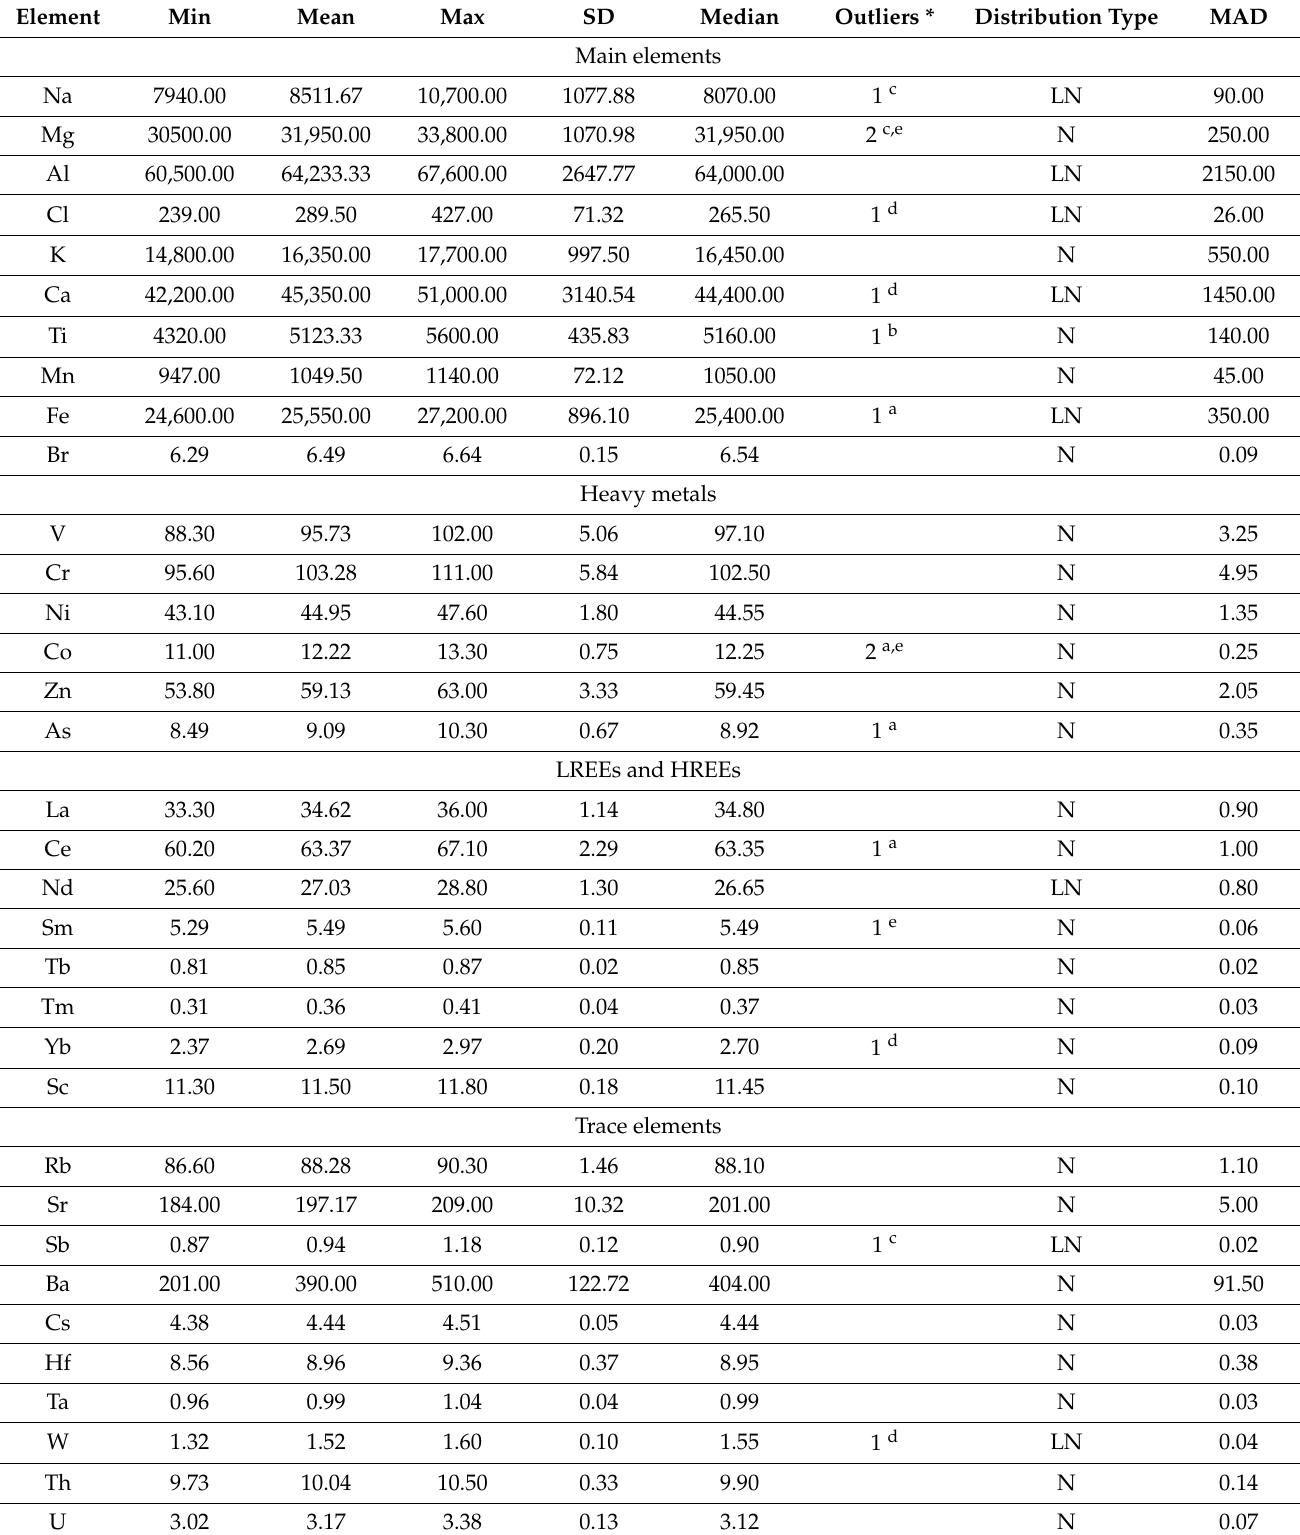
Table 2. Elements concentration in the Amara Lake bottom sediment core (83–94 cm) in mg · kg − 1 . N normal distribution, LN log-normal